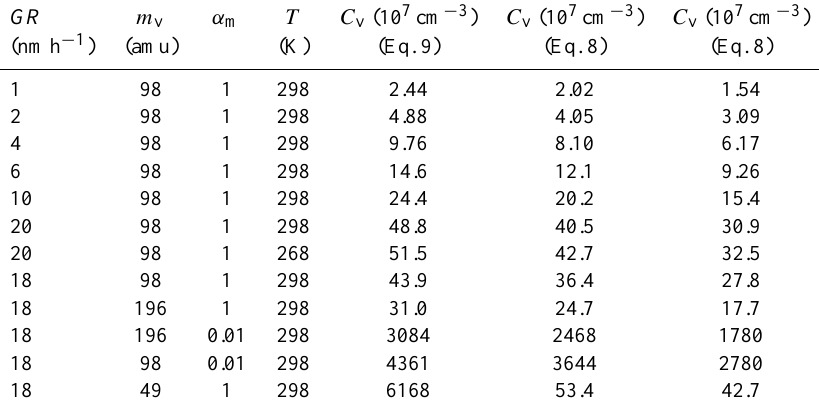
Table 1. The effect of vapor molecule mass, temperature and mass accomodation coefficient on the concentration of condensable vapor leading to particle growth rate GR . Particle density and vapor liquid phase density are both assumed to be 1.83 g cm − 3 . Growth rate is calculated over the size ranges 3–10nm (2nd and 3rd columns from right), and 1.5–3nm (1st column from right). Note that the values of C v on the 3rd column from right differ from those given in Table 1 of Kulmala et al. (2001) because they have assumed particle density 1.0gcm − 3 .